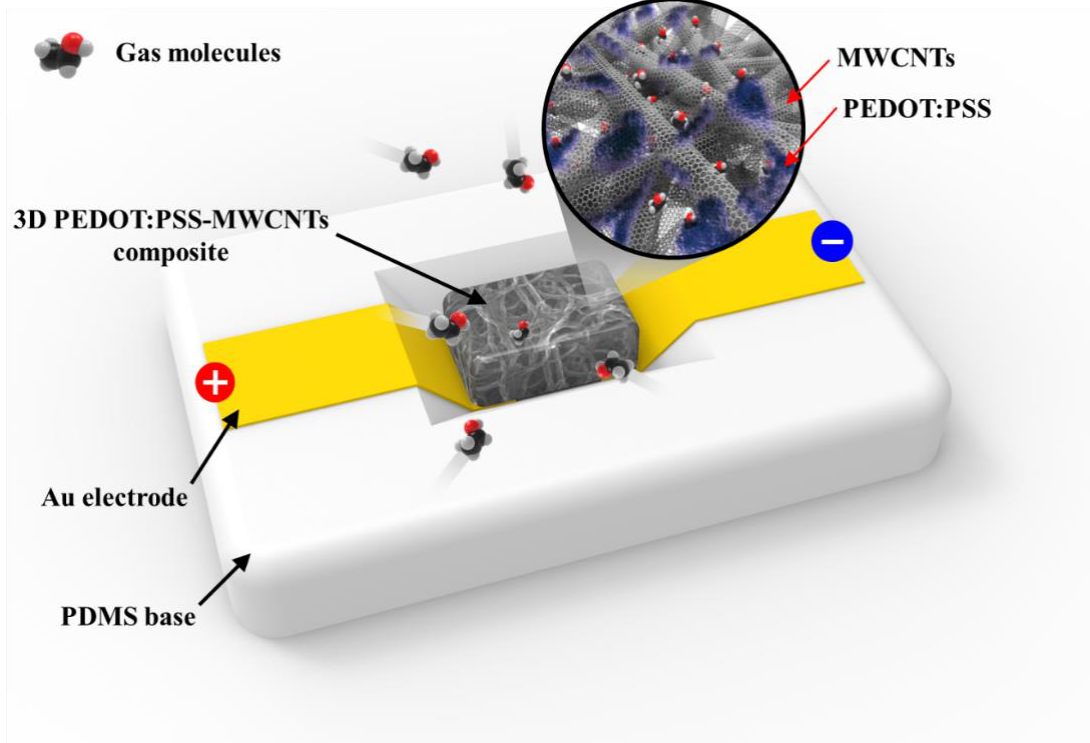
Figure 1. Schematic of gas-sensing module with 3D poly (3,4-ethylenedioxythiophene)/poly (4- styrenesulfonate) (PEDOT:PSS)- multiwalled carbon nanotubes (MWCNT) composite. PEDOT:PSS (4-styrenesulfonate) (PEDOT:PSS)- multiwalled carbon nanotubes (MWCNT) composite.